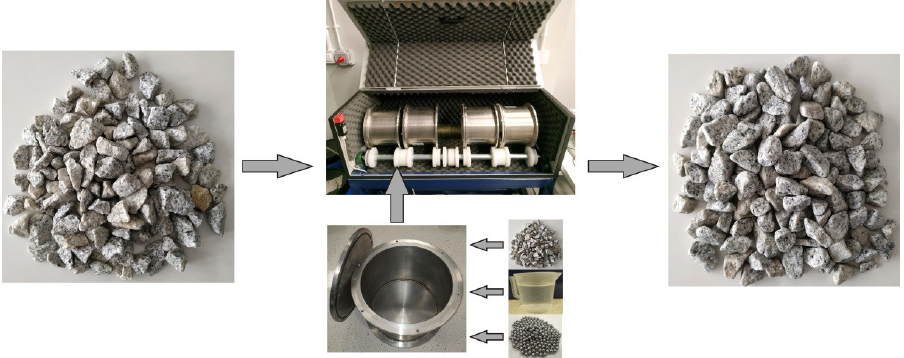
Figure 1. The M DE test procedure.